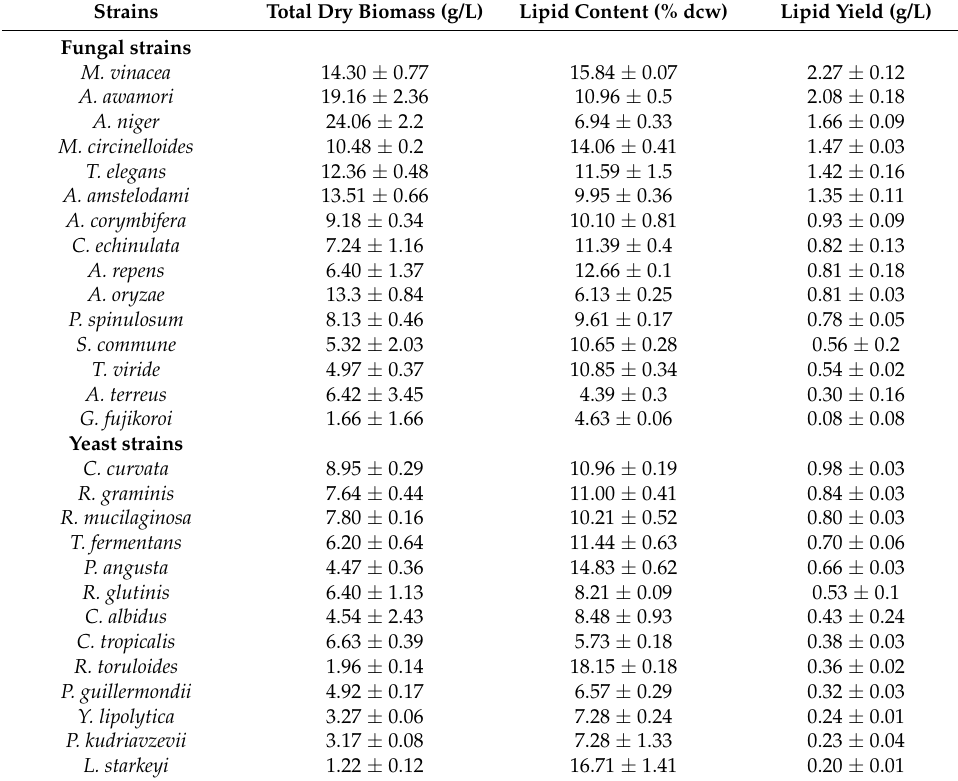
Table 3. Total dry biomass, lipid content and lipid yield of fungal and yeast strains grown on crude distillery spent wash (DSW) for 10